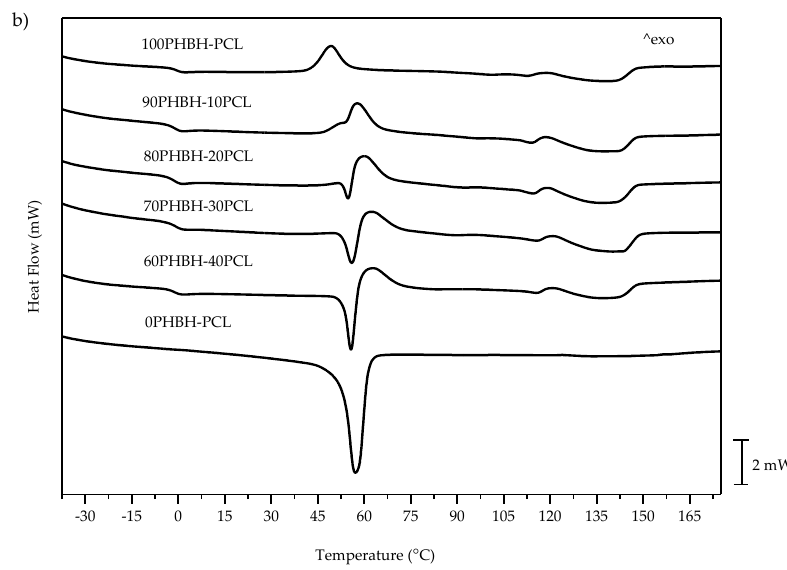
Figure 1. Comparative plot of the di ff erential scanning calorimetry (DSC) thermograms of PHBH, PCL and PHBH / PCL blends with di ff erent PCL wt %: ( a ) first heating cycle after processing and aging for 15 days, ( b ) 2nd heating after cooling ( a ) at a controlled rate.